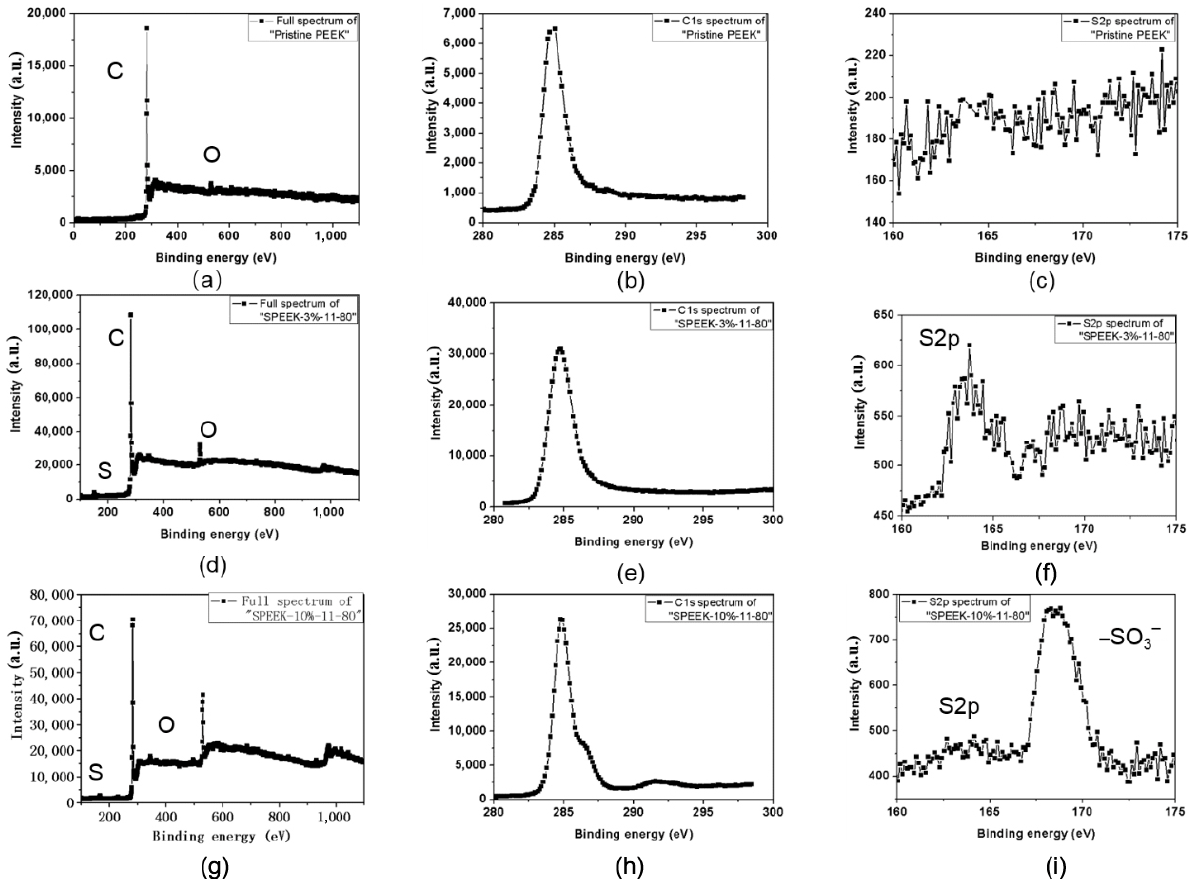
Fig. 2 Full XPS, C 1s, and S 2p spectra of (a–c) pristine PEEK, (d–f) SPEEK-3%-11-80, and (g–i) SPEEK-3%-11-80 powders. C and O peaks were detected in the pristine PEEK powder. In addition to these peaks, S peaks were recorded in the sulfonated PEEK